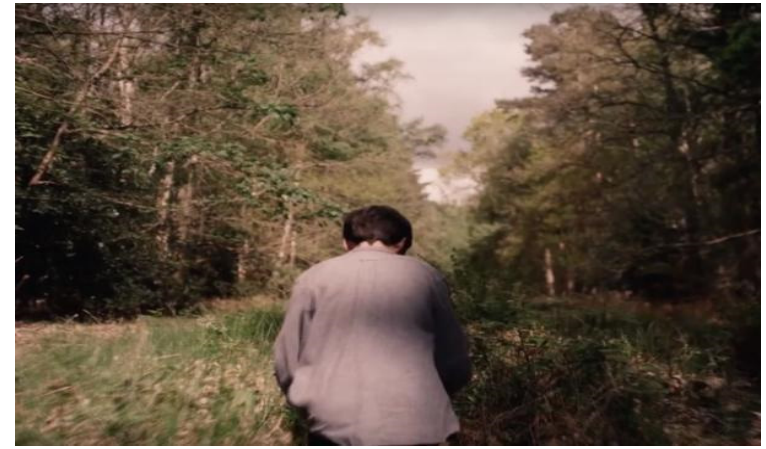
Figure 1. James is torturing cats in the woods Pilot (1 × 01). Source: Clerkenwell Films .